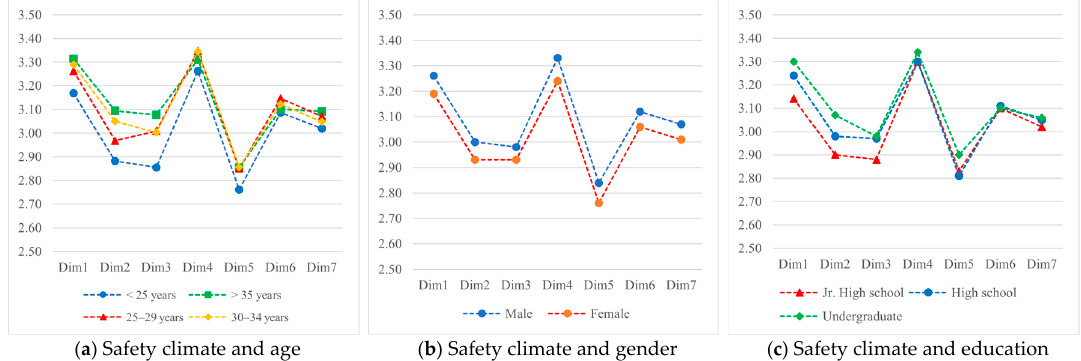
Figure 2. Safety climate scores based on ( a ) age, ( b ) gender, and ( c ) education level.